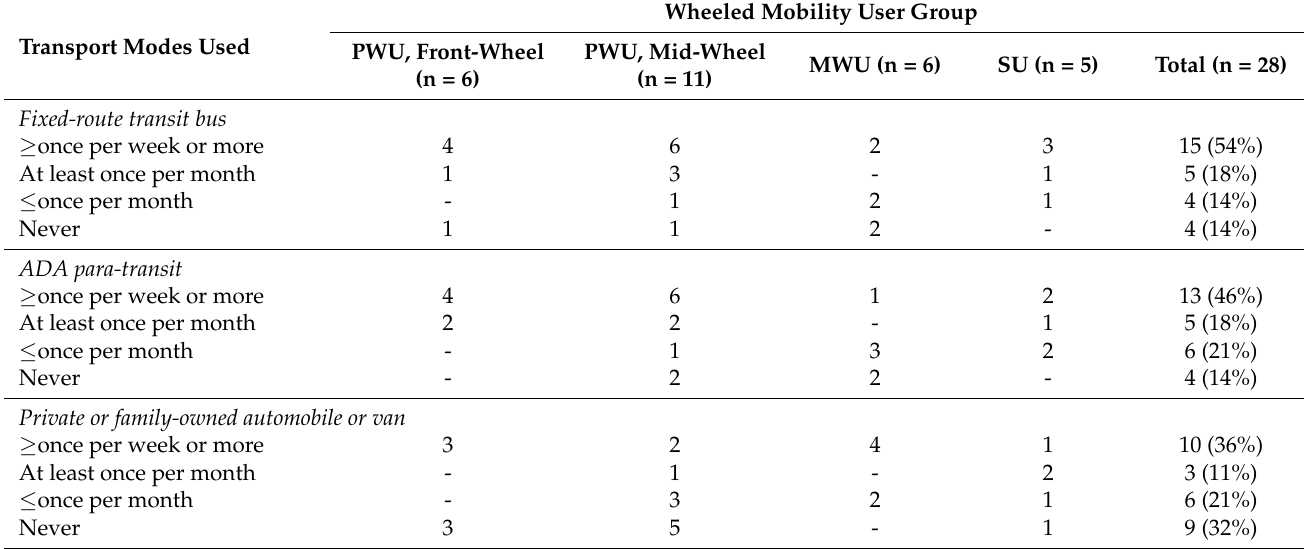
Table 3. Self-reported frequency of using different transportation modes stratified by wheeled mobility user group (n = 28).